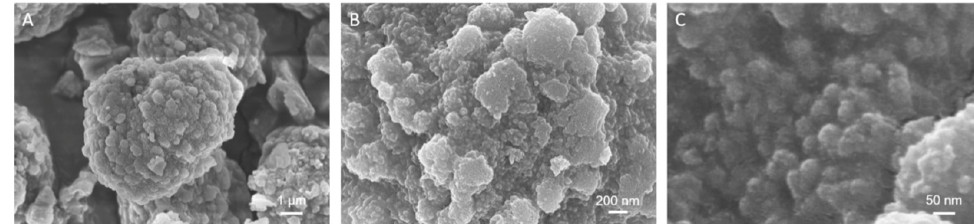
Figure 6. FE-SEM images of LPMS-HRP_PEG material at low ( A ) and high ( B , C ) magnifica-